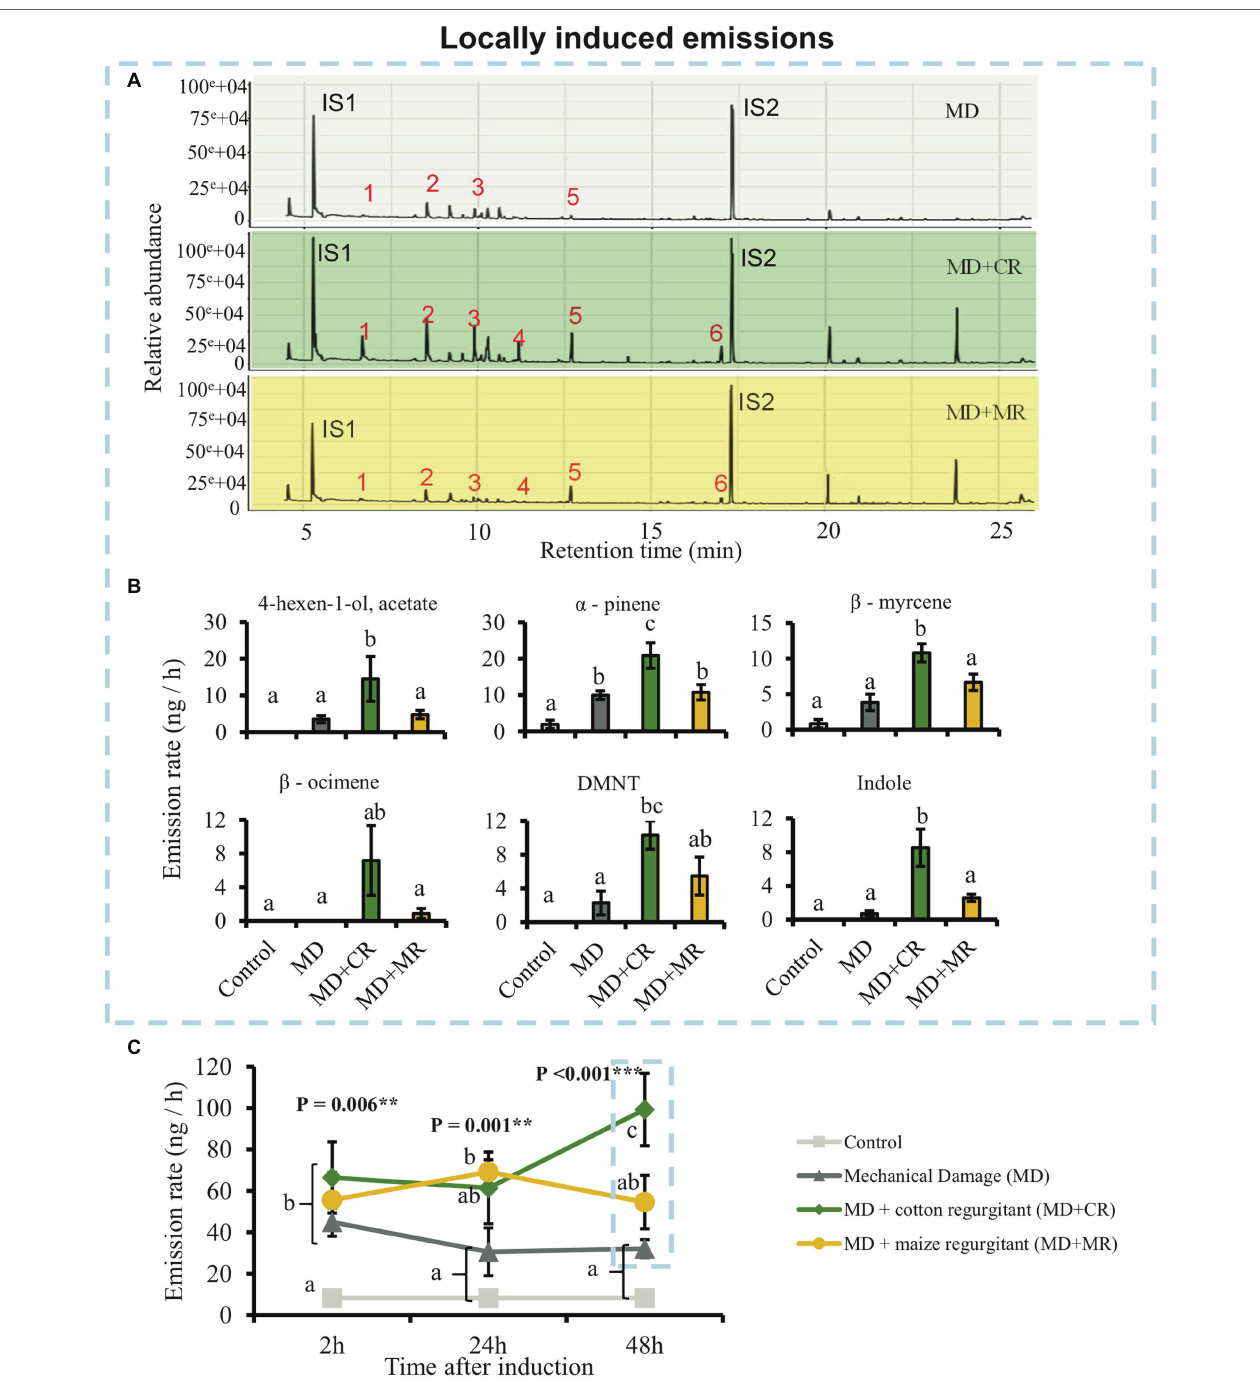
FIGURE 2 | Cotton plants locally emit different amount of volatiles in response to elicitation by different caterpillar regurgitants. Plants were subjected to the following treatments: undamaged (Control), mechanically damaged (MD), mechanically damaged and application of regurgitant of cotton-fed Spodoptera exigua (MD + CR), and mechanically damaged and application of regurgitant of maize-fed S. exigua (MD + MR; n = 4–5). (A) Typical GC-MS chromatograms of HIPV from cotton plants 48 h after elicitation. The identities of the compounds are 1: 4-hexen-1-ol, acetate; 2: α -pinene; 3: β -myrcene; 4: β -ocimene; 5: DMNT; 6: Indole; and IS1 and IS2: internal standards (20 ng/ μ l), n -octane and nonyl acetate, respectively. (B) Average (±SE) of the most representative compounds emitted by cotton plants 48 h after elicitation. Different letters indicate significant differences between treatments ( p < 0.05). (C) Average (±SE) of total amount of volatiles emitted by treated cotton plants 2, 24, and 48 h after elicitation. Different letters indicate significant differences between treatments within each time point. p values are given for treatments [generalized linear model (GLM; family, Gaussian)] followed by pairwise comparisons of Least Squares Means (LSMeans). ** p < 0.01, *** p <